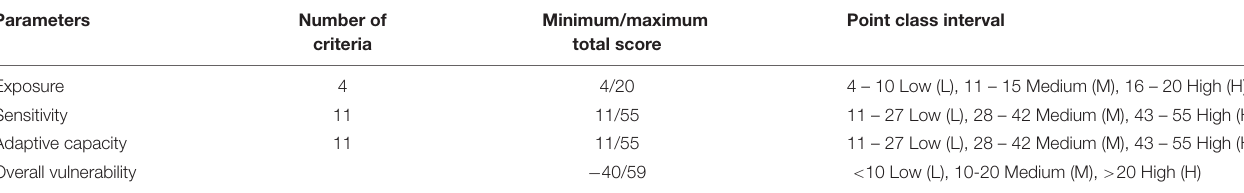
TABLE 4 | Ranking classification for vulnerability parameters, adapted from Jacinto et al. (2015).